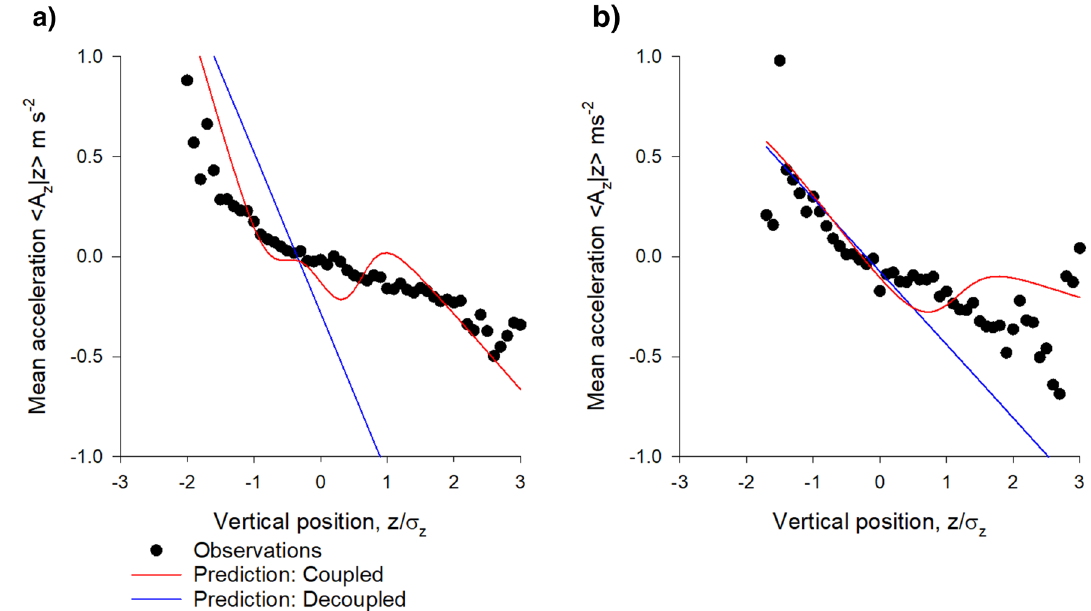
Figure 4. Mean accelerations are consistent with slabs being coupled. Data (•) are shown ( a ) for swarm (Ob1) which contain on average 94 individuals and ( b ) for a swarm (Ob5) which contains on average 22 individuals. Shown for comparison are model predictions for coupled slabs, Eq. (2) (red lines) and for decoupled slabs, Eq. (3) (blue lines). Data are taken from Sinhuber et al. 14